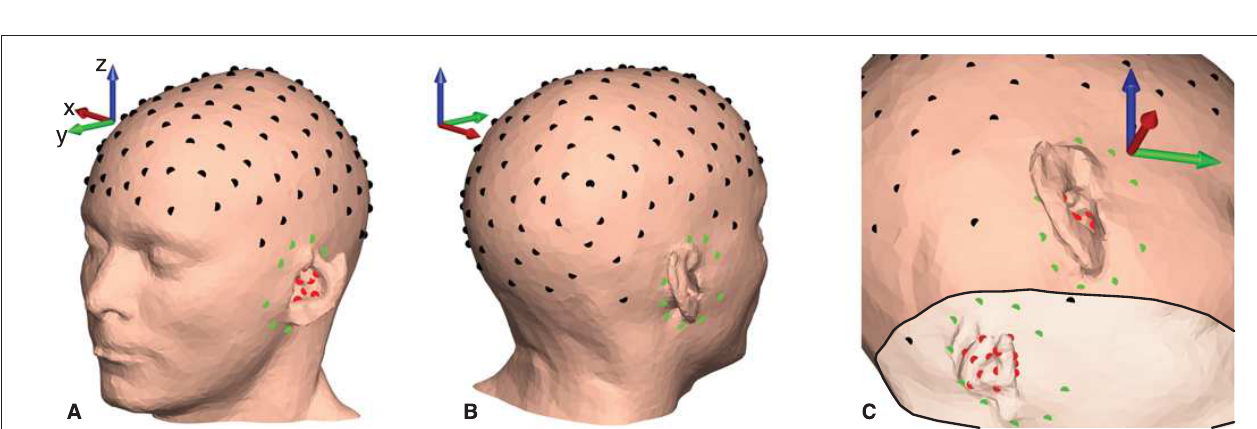
FIGURE 4 | The head model mesh grids for Subject C. (A) The scalp, (B) The outer skull, (C) The inner skull, and (D) The brain mesh grid.